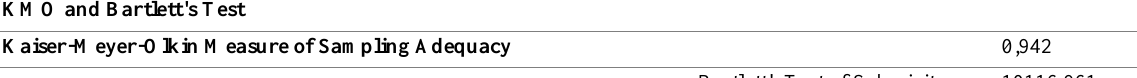
Table 3: Job Satisfaction (Dependent Variable) KMO and Bartlett's Test KMO and Bartlett's